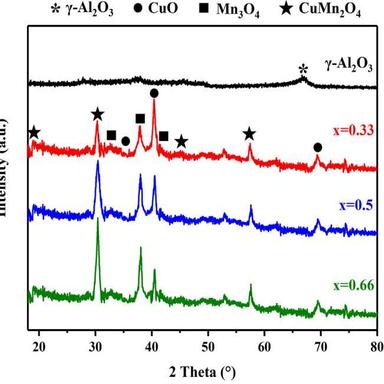
a)-c) XPS spectra for the Mn2p, Cu2p, and O1s regions of the MnxCu1-xOy/γ-Al2O3 catalysts; d) UV–Vis spectrum of the MnxCu1-xOy/γ-Al2O3 samples; e) EPR spectra of the γ-Al2O3 and MnxCu1-xOy/γ-Al2O3 catalysts; f) Py-FTIR spectra of the γ-Al2O3 and MnxCu1-xOy/γ-Al2O3 catalysts after pyridine desorption at 150 °C.